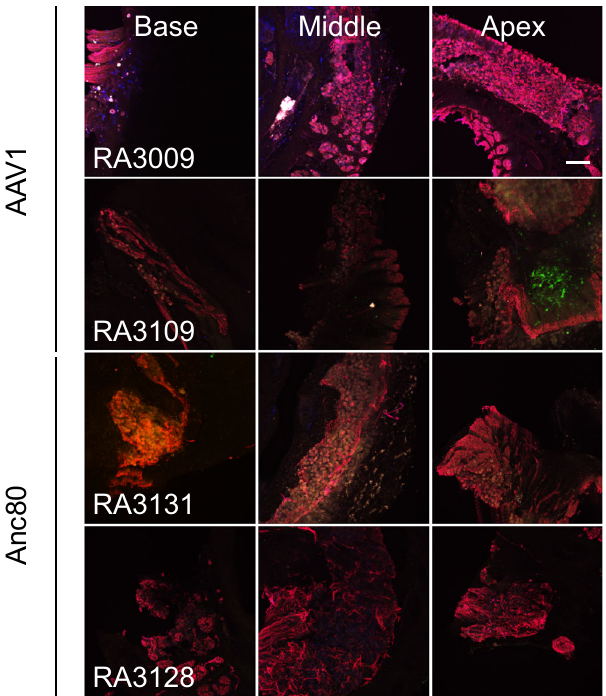
Fig. 4 In vivo transduction of the spiral ganglion with AAV1 and Anc80L65 in rhesus macaques. Representative images (from 4 of 5 animals) from the basal, middle, and apical region of the spiral ganglion from each animal reveal hardly any transduction. eGFP (green) signal in the modiolus was only observed in one small area of an apical section from animal RA3109 that was injected with AAV1. Same confocal settings were used to obtain all images. Red, neuro fi lament-labeled neuronal structures. Scale bar, 50 µ